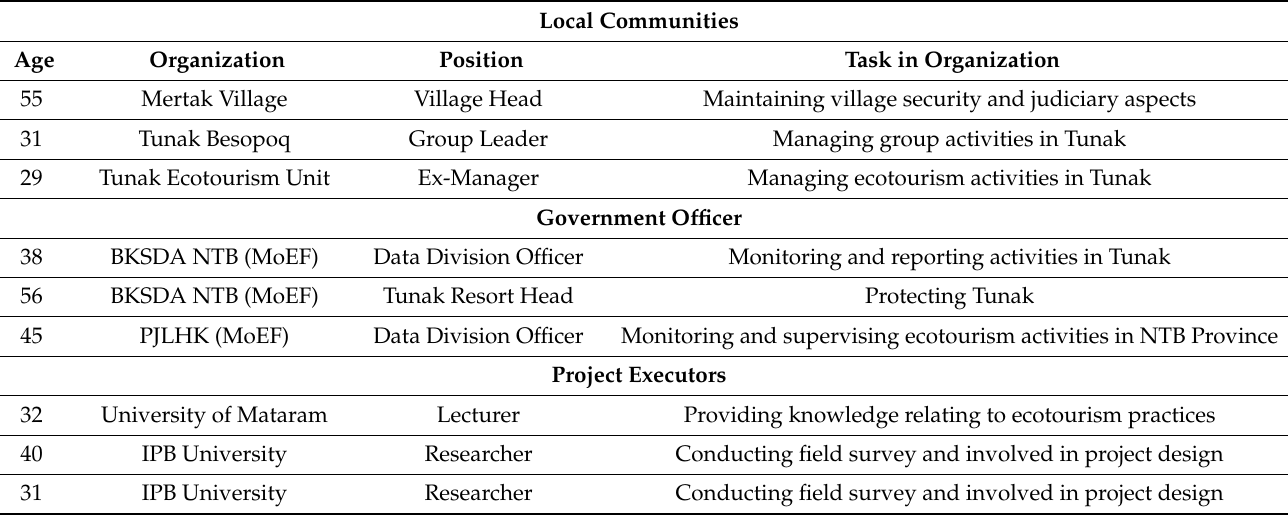
Table 1. General Characteristics of Key